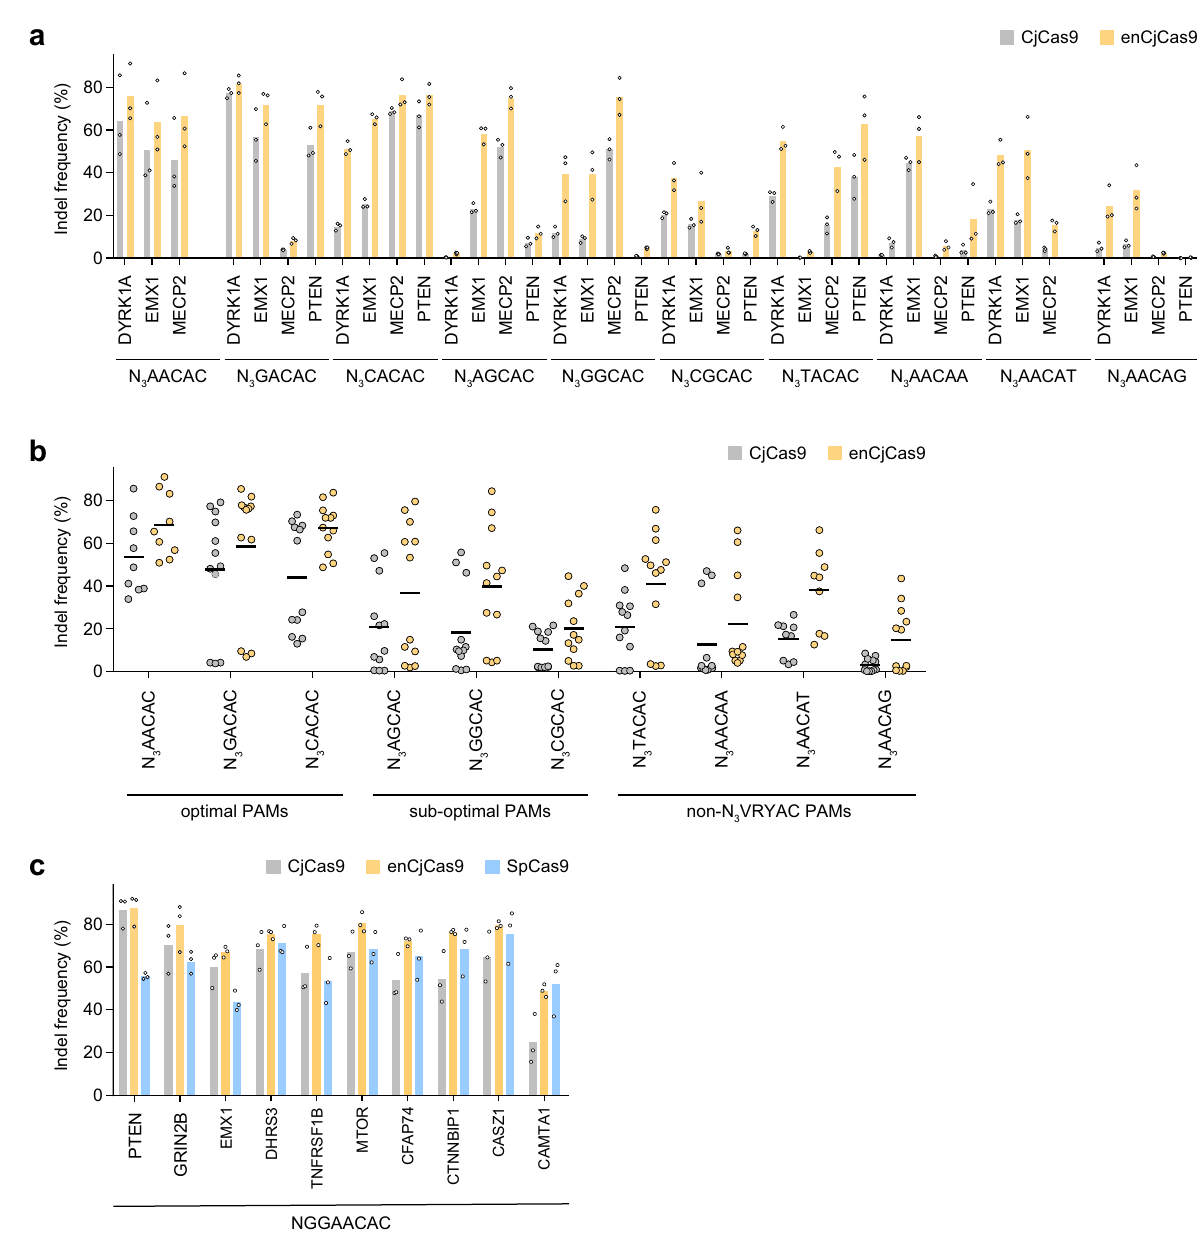
Fig. 2 Genome editing by CjCas9 and enCjCas9. ( a ) Indel formation by CjCas9 (gray) and enCjCas9 (orange) at endogenous target sites in HEK293Ta cells ( n = 3). ( b ) Summary of the genome-editing ef fi ciencies of CjCas9 (gray) and enCjCas9 (orange) in ( a ). Bars indicate medians. ( c ) Indel formation by CjCas9 (gray), enCjCas9 (orange), and SpCas9 (blue) at endogenous target sites in HEK293Ta cells ( n =